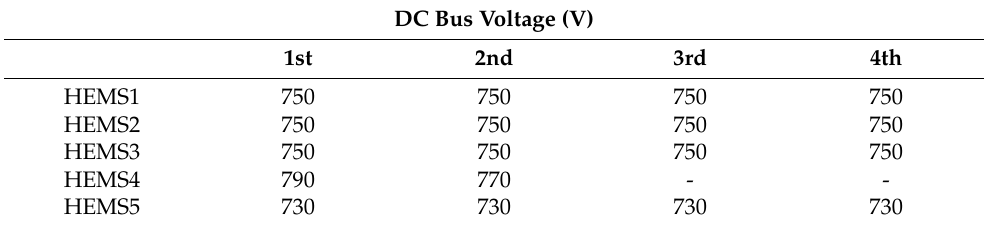
Table 9. Most frequent DC Bus Voltage values, measured by the HEMSs and sent to the